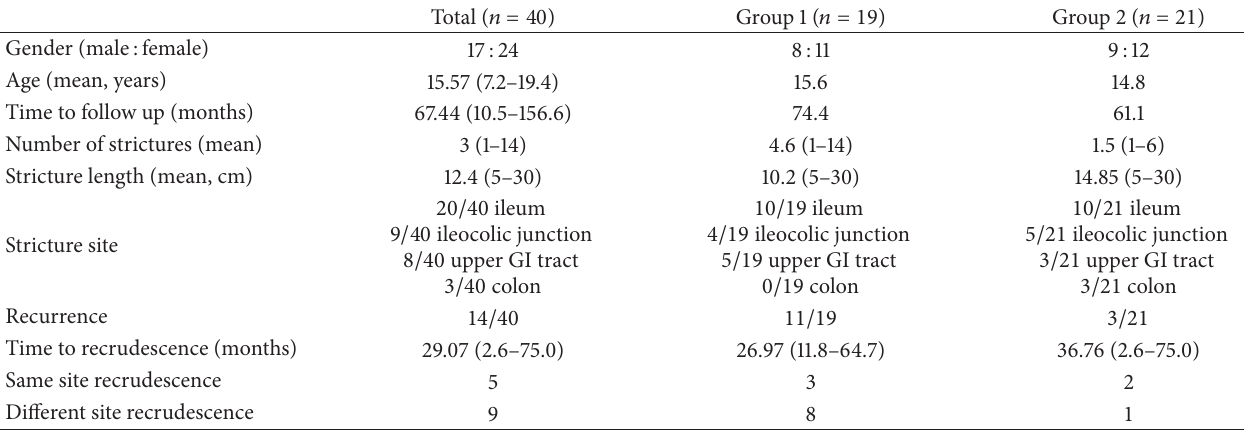
Table 2: Characteristics of all procedures, of Group 1, strictureplasty, and of Group 2,